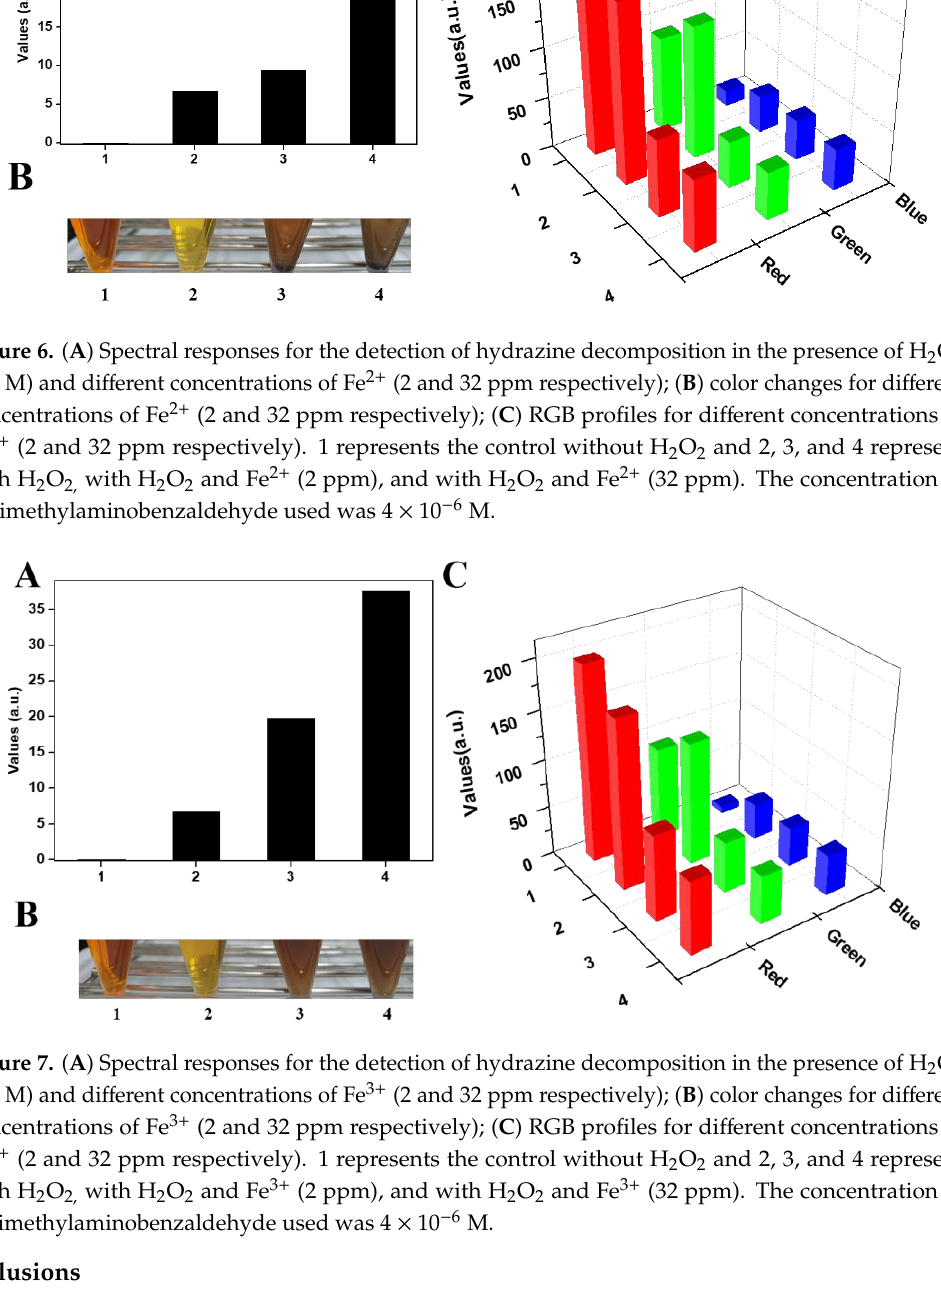
Figure 5. ( A ) Spectral responses for detection of hydrazine decomposition in the presence of H 2 O 2 (0.2 M) and different metal ions (32 ppm respectively); ( B ) color changes for different metal ions; and ( C ) RGB profiles of different metal ions. 1 represents the control and 2, 3, 4, 5, and 6 represent Fe 2+ , Fe 3+ , Mn 2+ , Cr 6+ , and Ni 2+ . The concentration of p -dimethylaminobenzaldehyde used was 4 × 10 −6 M. As shown in Figures 6A and 7A, the decomposition of hydrazine was relatively high at concentrations of 32 ppm, compared to 2 ppm, in the presence of Fe 2+ or Fe 3+ . This suggests that hydrazine decomposition could be triggered by hydroxyl radicals generated in the presence of both Fe 2+ or Fe 3+ and H 2 O 2 . As shown in Figures 6B and 7B, the color changes of the samples in the presence of different Fe 2+ or Fe 3+ concentrations were investigated using RGB values. The red (R) and green (G) significantly increased in concentration-dependent manners in the presence of Fe 2+ or Fe 3+ , while the blue (B) value was nearly unchanged compared to the control. Therefore we propose that a colorimetric assay for detection of hydrazine decomposition for a chemical decontamination process